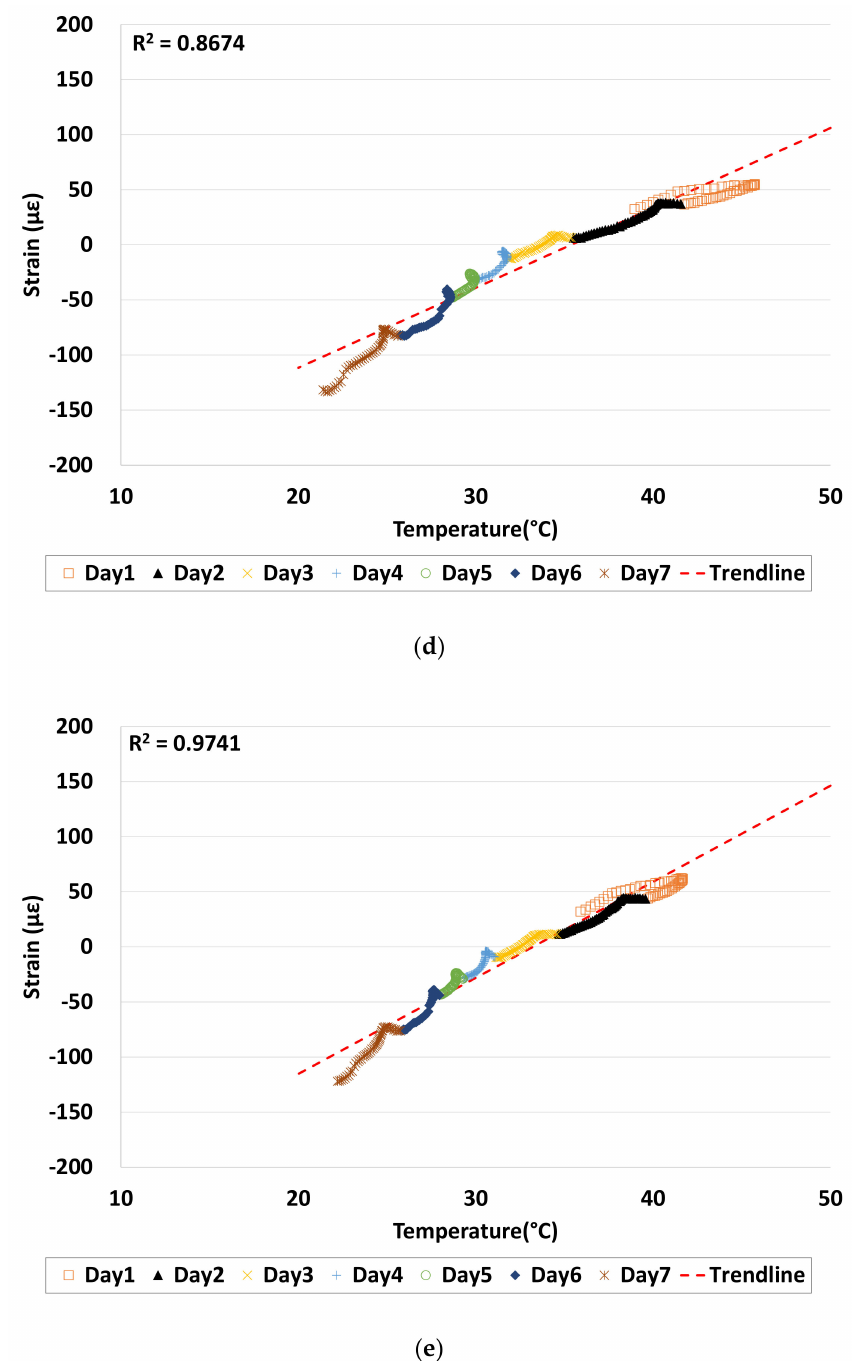
Figure 11. Relationship between the real strain and concrete temperature at the slab corner for the first seven days: ( a ) 50 mm depth, ( b ) 150 mm depth, ( c ) 250 mm depth, ( d ) 350 mm depth, and ( e ) 450 mm